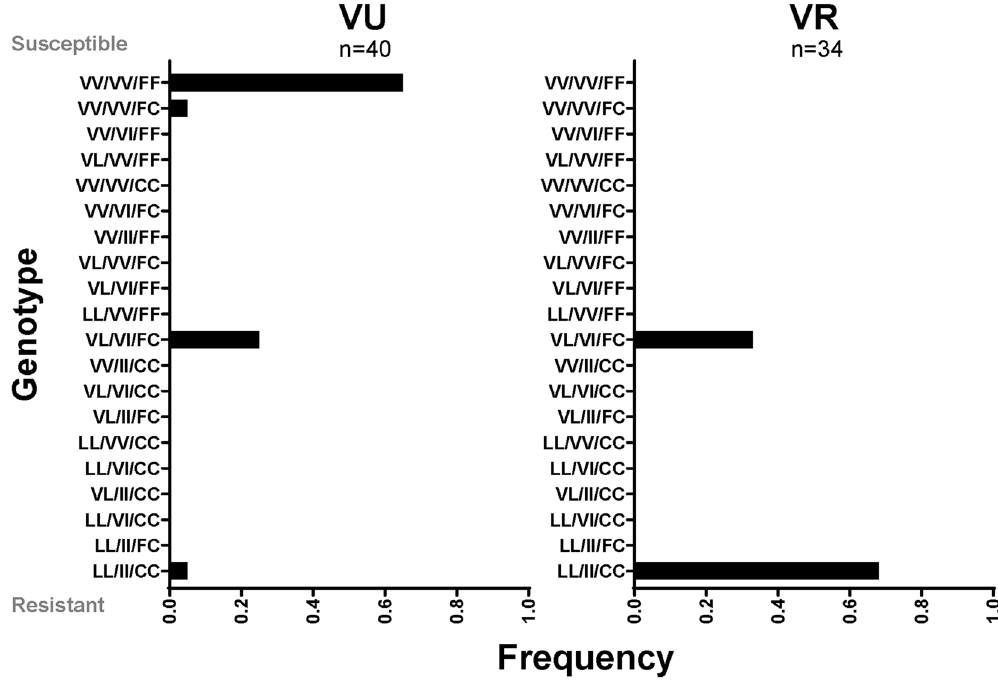
Figure 2. KDR genotypes present in VU and VR. Resistant alleles are V410L, V1016I, F1534C; the order of genotypes is 410, 1016, 1534. VV/VV/FF is indicative of a complete absence of KDR alleles (homozygous susceptible), LL/II/CC is homozygous resistant and VL/VI/FC represents heterozygosity at all 3 alleles (Prism GraphPad version 8.0., https:// www. graph pad. com/ scien tific- softw are/